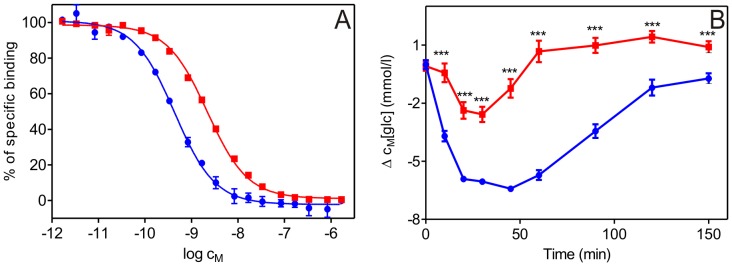
Binding affinities and in vivo activities of human insulin and [GlnB22]-insulin.(A) Inhibition of the binding of human [125I]-insulin to the plasma membrane of IM-9 cells by human insulin (blue) and [GlnB22]-insulin (red). (B) Insulin tolerance test of human insulin (blue) and [GlnB22]-insulin (red). Values are mean ±S.E., n = 10/group. ***p<0.01 compared to human insulin-treated group. Δ cM is the decrease in molar concentration of blood glucose in mmol/l adjusted for the impact of conditions during testing (represented by the application of saline).